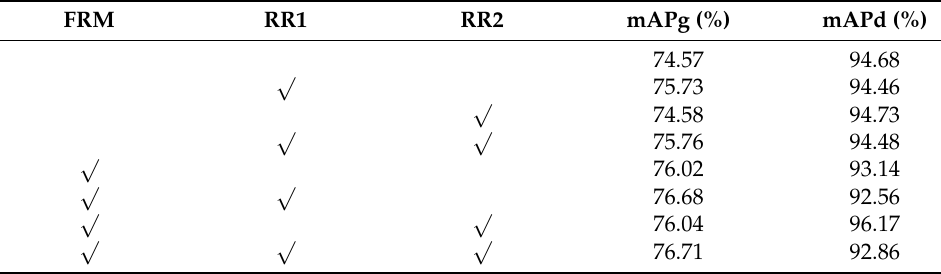
Table 4. Effect of Box Redistribution. Each colour represents a different comparison